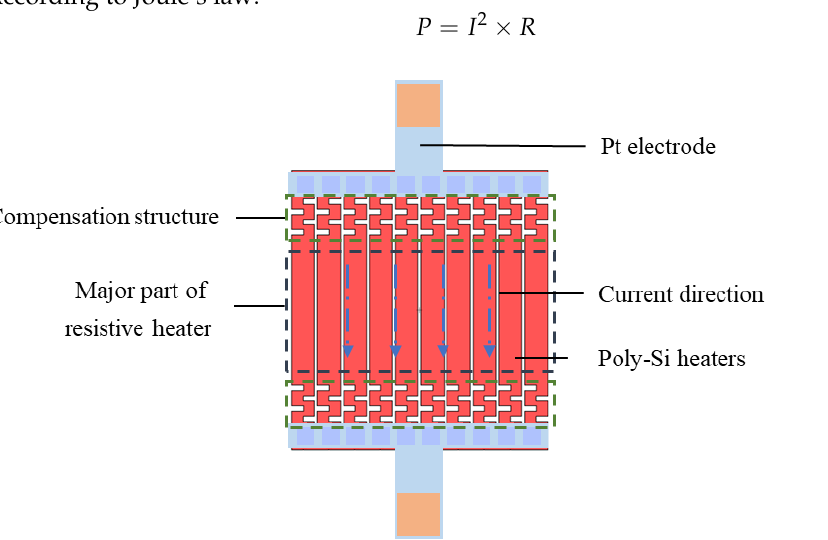
Figure 3. Schematic diagram of the poly-Si resistive heaters with designed heat compensation struc- tures.